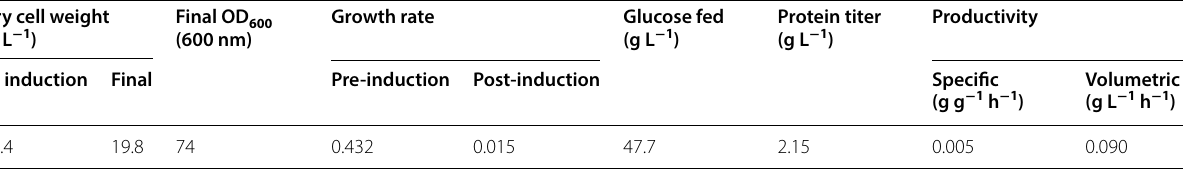
Table 1 A summary of parameters that were measured in the production of recombinant VP1 by fed-batch fermentation Dry cell weight (g L − 1 )